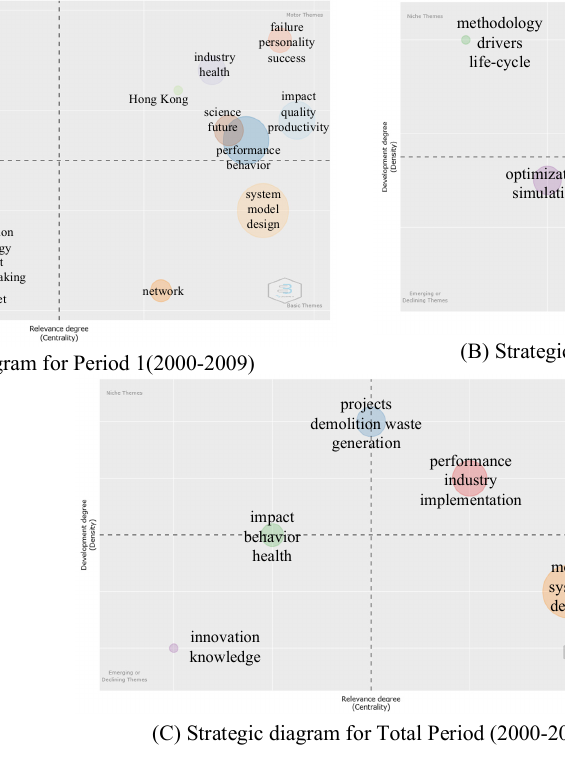
Figure 7. Strategic diagrams for each period (generated by Bibliometrix R ).